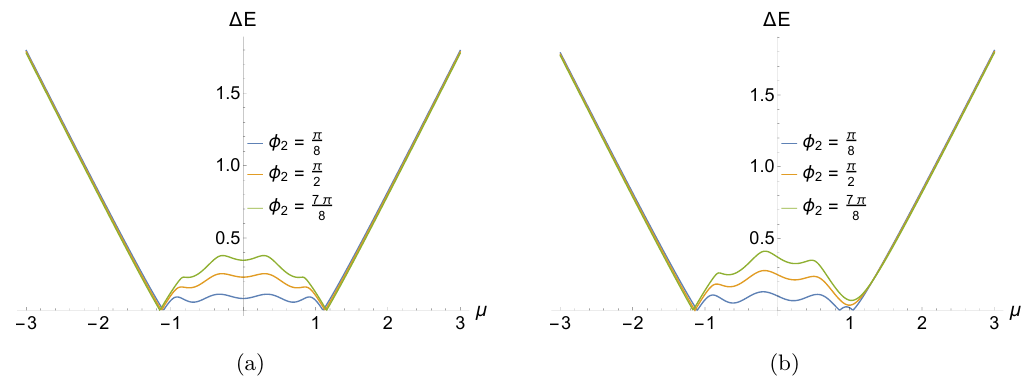
Figure 9 . The energy gap between the ground state and first excited as a function of µ with , a = 1 , b = 2 . We have fixed φ J = 1 , ∆ = 1 2 parameters we note a pair of values for µ exhibit a closing energy gap provided | φ chain length is L = 7 . In this case we observe only a single value for µ for which gap closing occurs for | φ . We find three values for which this occurs for | φ 2 | > | φ 1 |